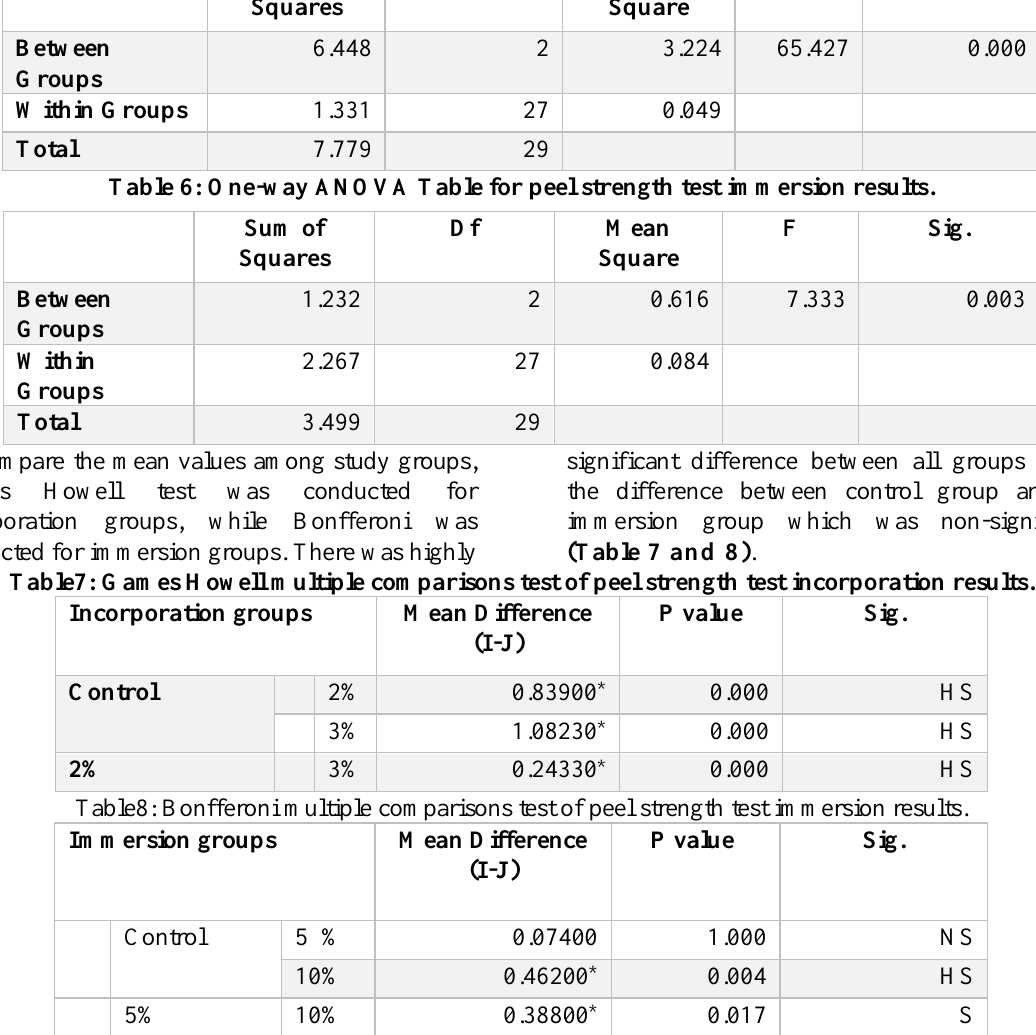
Table 6: One-way ANOVA Table for peel strength test immersion results.